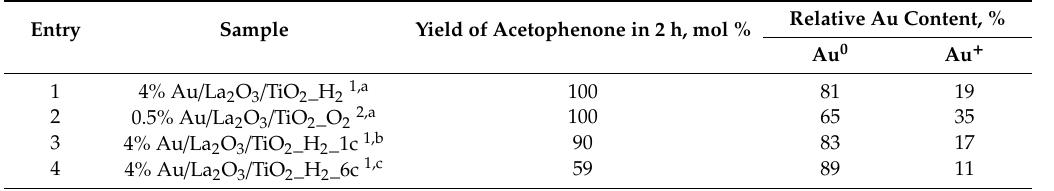
Table 8. Catalytic results of the most active catalysts in the peroxidative and aerobic oxidation of 1-phenylethanol and contribution of various electronic states of gold in these catalysts, calculated by XPS.